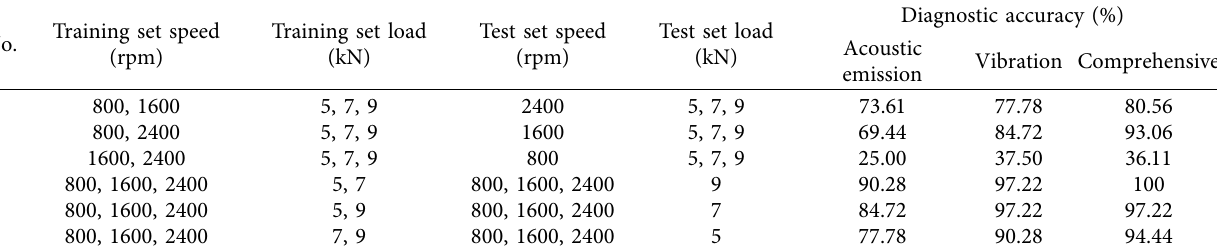
Table 4: Accuracy rate of multicondition fault diagnosis.